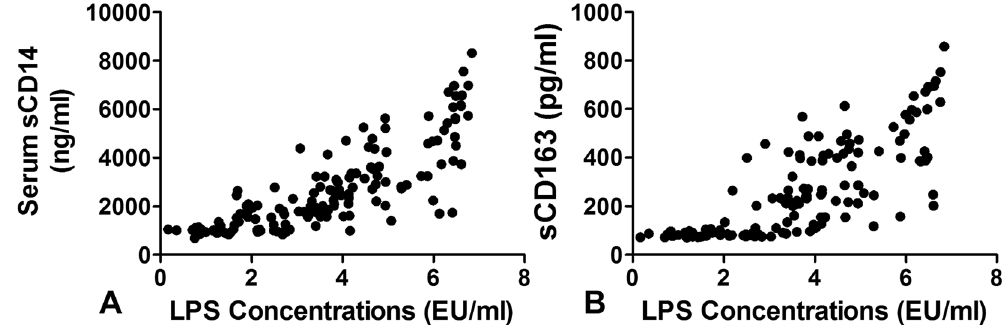
Figure 3. Relationship between serum LPS and sCD14 ( A ) and sCD163 ( B ). The relationship between serum LPS and sCD14/sCD163 was not linear; however, the correlation was evident when the serum LPS > 2 EU/ml which is consistent with the range we observed subjects with excessive